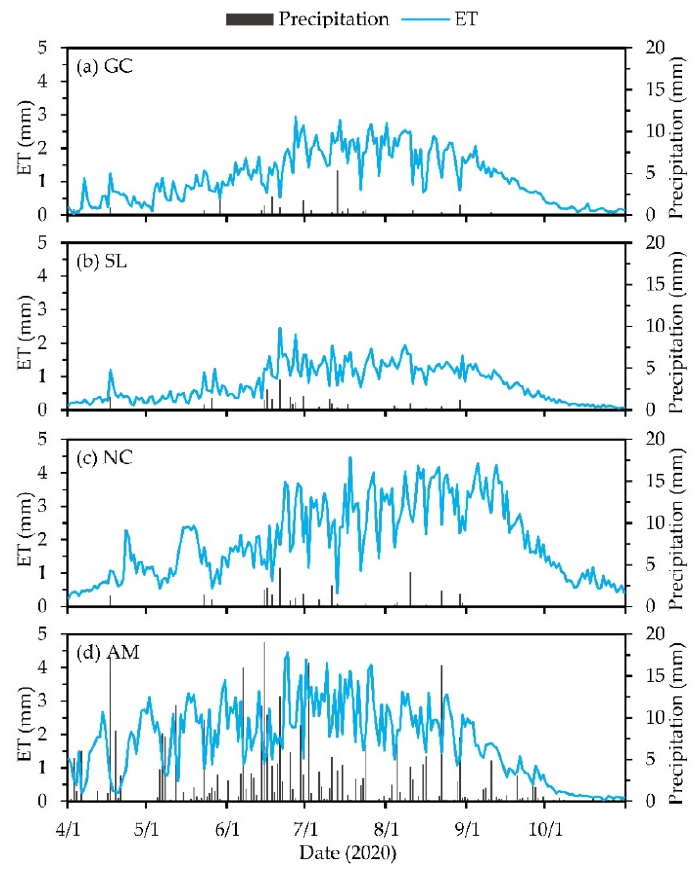
Figure 6. Temporal variation of evapotranspiration and precipitation at the four observation stations in the Qaidam Basin in